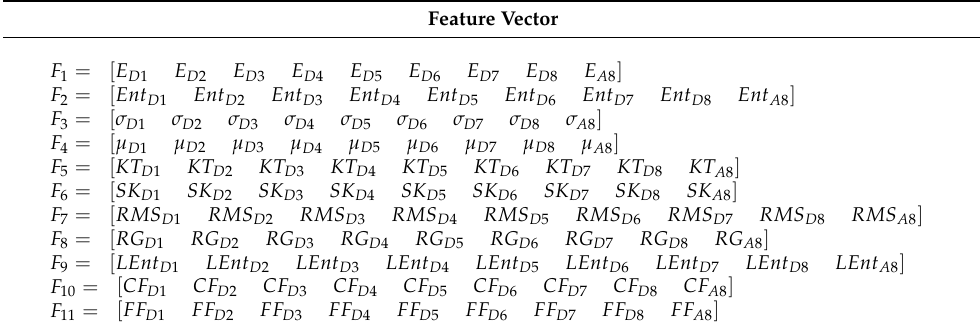
Table 3. Creation of feature vectors from statistical parameters, adapted from: